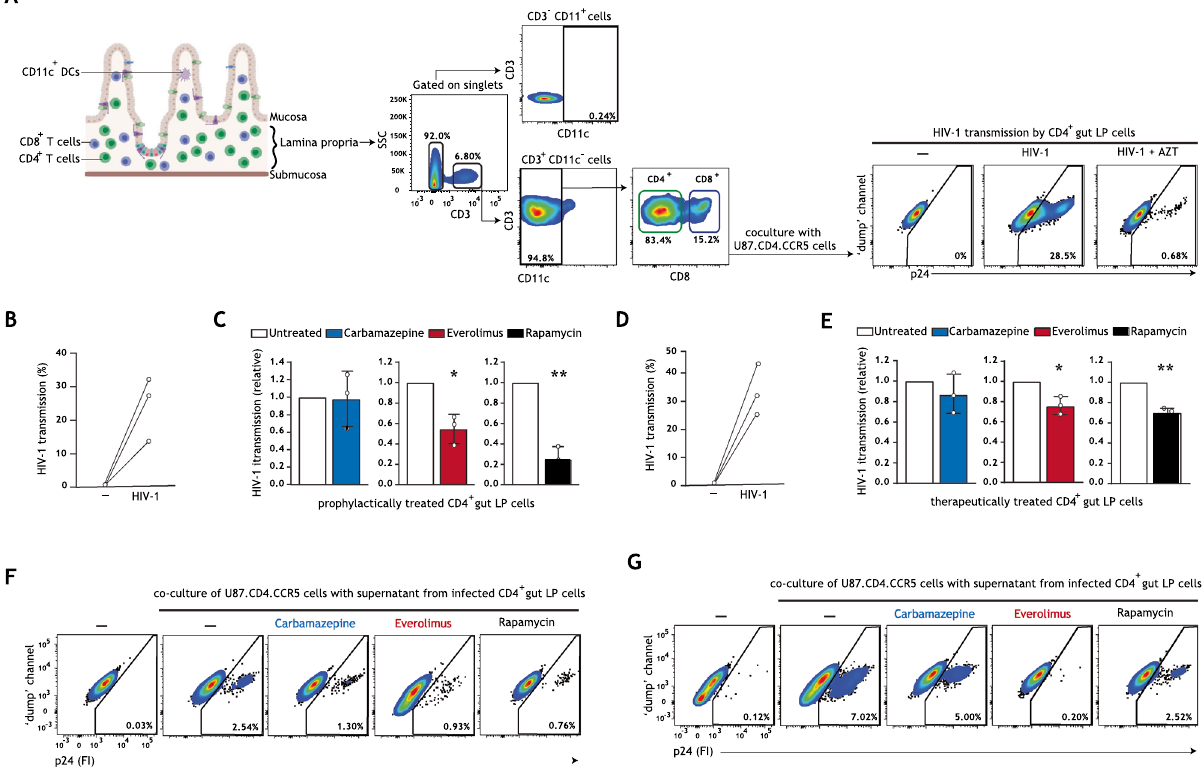
Figure 4. Autophagy-enhancing drugs everolimus and rapamycin limit intestinal HIV-1 transmission and reduce ongoing HIV-1 replication in intestinal CD4 + T cells. ( A ) Human intestinal lamina propria lymphocytes (LPLs) were isolated as previously described 40 . Gating strategy employed to identify gut CD4 + T cells is shown; an extended gating strategy is available in Figure S7D, Supplementary Information. Following HIV-1 infection, LPLs were washed extensively to remove input virus, and subsequently co-cultured with permissive U87.CD4. CCR5 cells for 72 h. HIV-1 transmission by gut LPLs was determined by intracellular p24 staining; treatment of LPLs with HIV-1 replication inhibitor AZT (zidovudine, 20 μM) confirmed productive intestinal HIV-1 infection. ( B , C ) LPLs were prophylactically treated with carbamazepine (100 μM), everolimus (5 nM), or rapamycin (100 nM) for 15 h, or left untreated, followed by infection with HIV-1 NL4.3BaL for 24 h. Gut LPLs were harvested and washed to remove input virus, and subsequently co-cultured with U87.CD4.CCR5 cells. HIV-1 transmission by LPLs was assessed in LPL-U87.CD4.CCR5 co-culture for 72 h, determined by intracellular p24 staining by flow cytometer. T cell-marker CD3 was used to exclude single LPLs and LPL- U87.CD4.CCR5 conjugates from analysis. A detailed graphical depiction of HIV-1 transmission by gut LPLs is available in Supplementary Information Figure S7E. Data are mean ± SE of n = 3 donors measured in duplicate. Open circles represent the mean of duplicates from each independent experiment. Untreated, HIV-1 infected cells was set at 1, * P < 0.05, ** P < 0.01, one-sample t test. ( D , E ) LPLs were infected with HIV-1 NL4.3BaL for 15 h, and subsequently therapeutically treated with carbamazepine (100 μM), everolimus (5 nM), or rapamycin (100 nM) for 24 h, or left untreated. Gut LPLs were harvested and washed to remove input virus, and subsequently co-cultured with U87.CD4.CCR5 cells. HIV-1 transmission by LPLs was assessed in LPL-U87.CD4.CCR5 co-culture for 72 h, determined by intracellular p24 staining by flow cytometer. T cell- marker CD3 was used to exclude single LPLs and LPL-U87.CD4.CCR5 conjugates from analysis. A detailed graphical depiction of HIV-1 transmission by gut LPLs is available in Figure S7F, Supplementary Information. ( F ) Following prophylactic treatment and infection with HIV-1 NL4.3BaL (as in B , C ), LPLs were extensively washed to remove input virus and replated in new medium in a 96-well plate. ( G ) Following infection with HIV-1 NL4.3BaL and therapeutic treatment (as in D , E ), LPLs were extensively washed to remove input virus and replated in new medium in a 96-well plate. ( F , G ) Supernatants from infected intestinal prophylactically— ( F ) or therapeutically—( G ) treated LPLs were collected 24 h after replating and co-cultured with U87.CD4. CCR5 cells for 72 h, to further confirm productive intestinal HIV-1 infection. HIV-1 infection of U87.CD4. CCR5 cells was determined by intracellular p24 staining by flow cytometer. Representative (n = 2 tissue donors) flow cytometry plots of HIV-1 infection of U87.CD4.CCR5 cells incubated with supernatants from HIV-1 infected gut